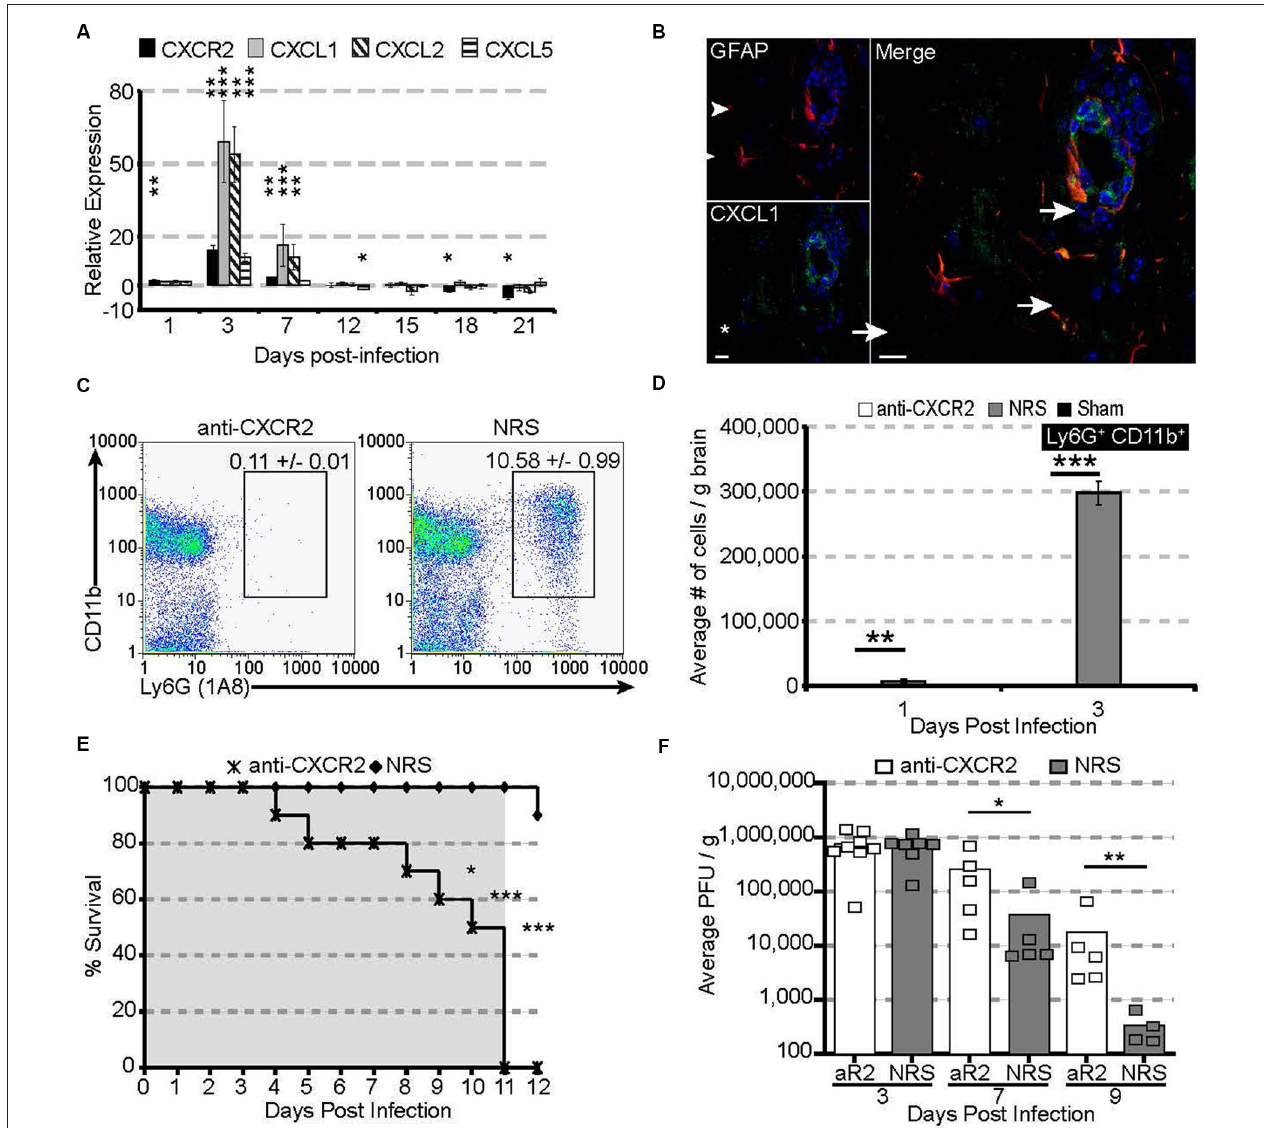
depicting the average frequency of neutrophils at day 3 are shown in panel. (D) Neutralization of CXCR2 blocks neutrophil (Ly6G + CD11b + ) infiltration into the CNS. (E) CXCR2 neutralization results in 100% morality by day 11 pi (shaded area indicates the treatment period) and (F) elevated viral loads within the brains of treated mice. NRS = normal rabbit serum treated mice. * p < 0.05, ** p < 0.01, *** p < 0.001 compared to NRS-treated